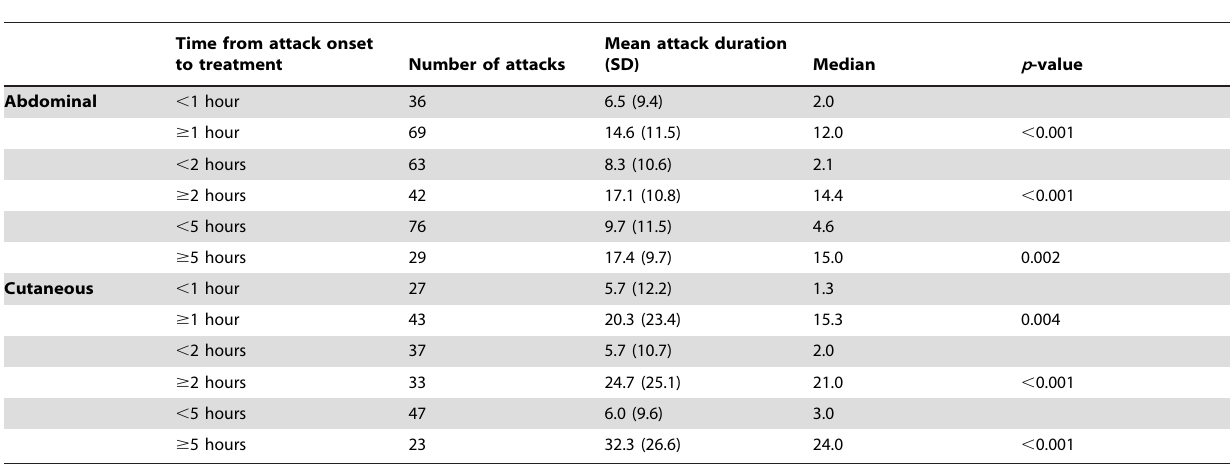
Table 4. Early treatment with icatibant and mean attack duration by attack location.